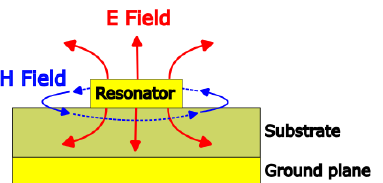
Figure 1. Electric (E- fi eld) and magnetic (H- fi eld) fi elds from microstrip structure.